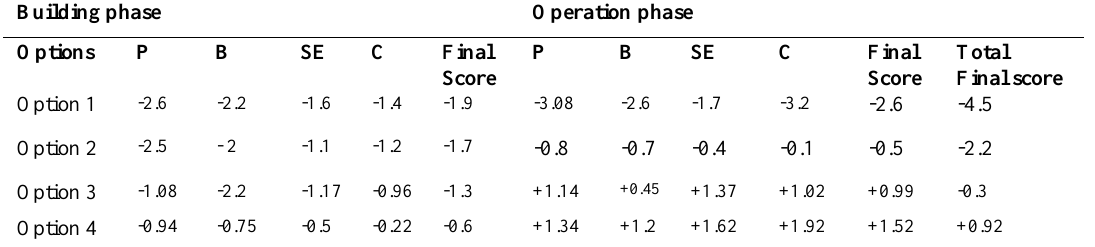
Table 7. Final score of options in the Iranian Leopold Matrix Building phase Operation phase Options P